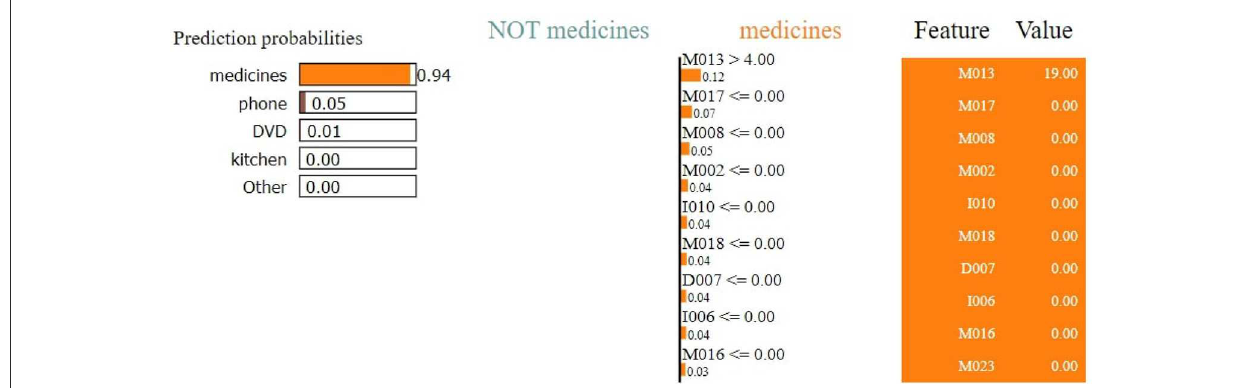
FIGURE9 Feature explainability.